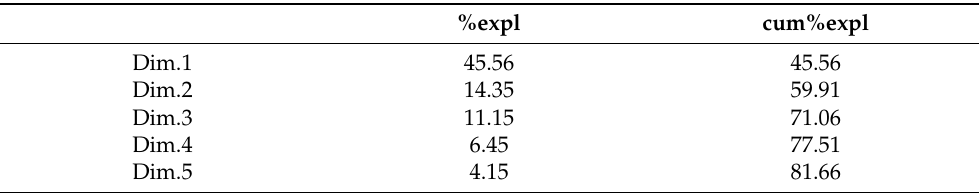
Table 2. Percentage of the variability explained (%expl) and cumulative percentage (cum%expl) explained by the first common components defined using